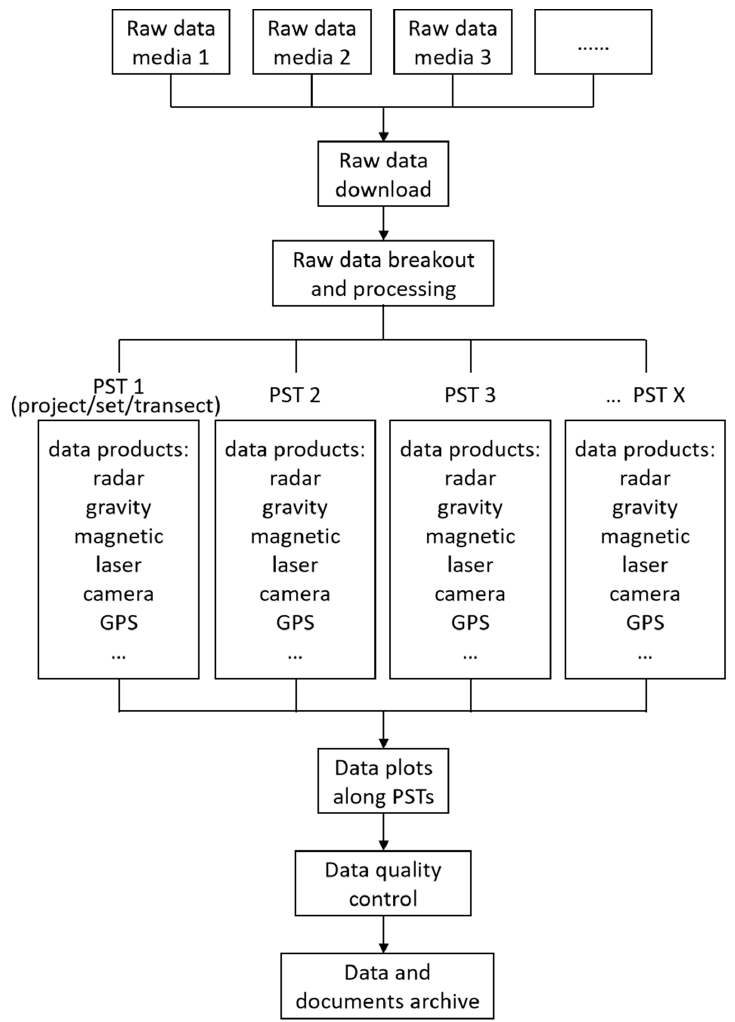
Figure 4. Flow chart of field data processing and quality control.